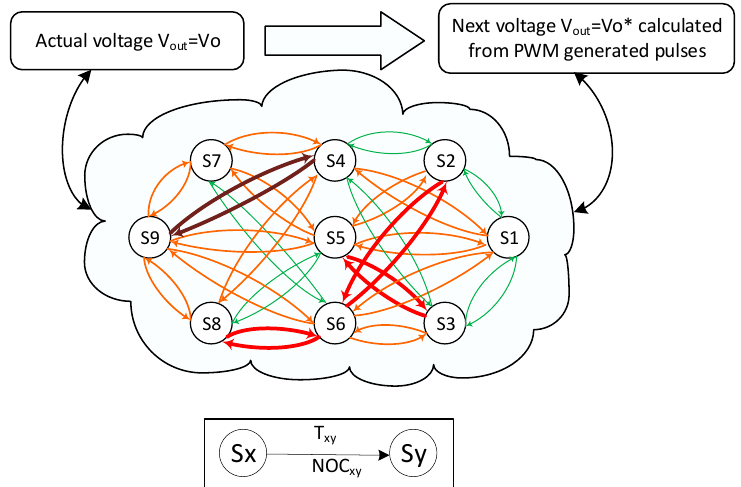
Figure 12. States of switching and associated trajectories when i(t) is positive.